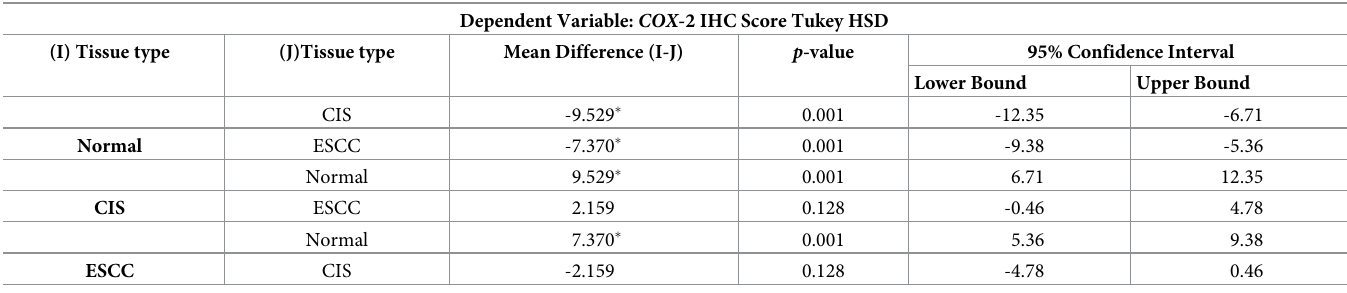
Table 3. COX -2 IHC Score Tukey HSD: Multiple